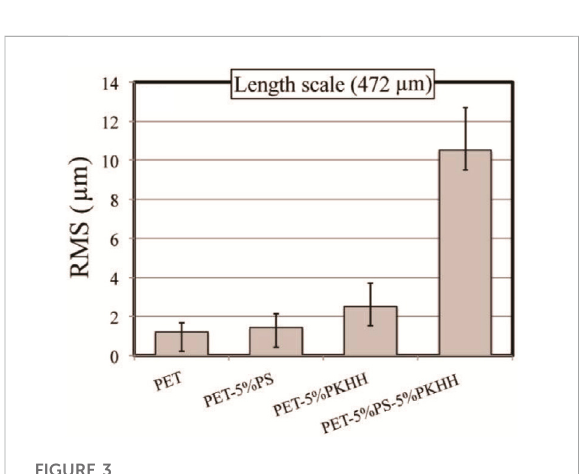
FIGURE 3 RMS surface-roughness for the PET., PET.-5wt%PS,